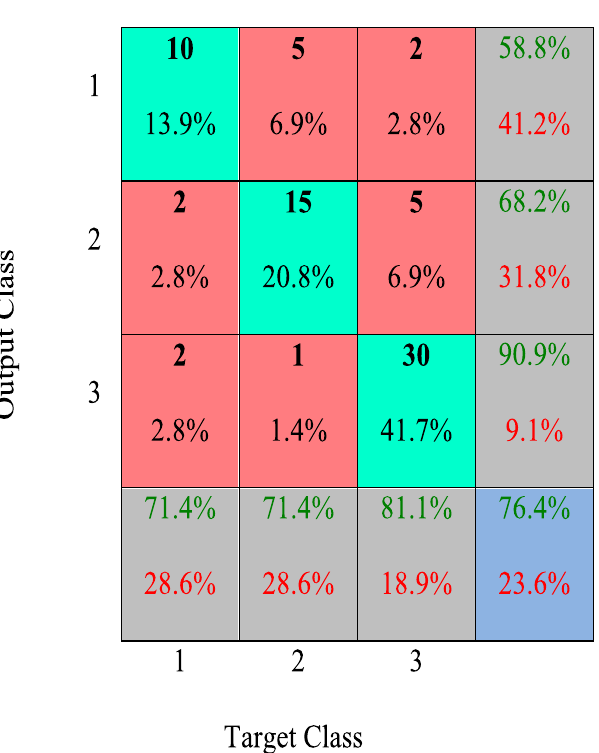
Figure 1. Confusion matrix for the ANN test data with architecture